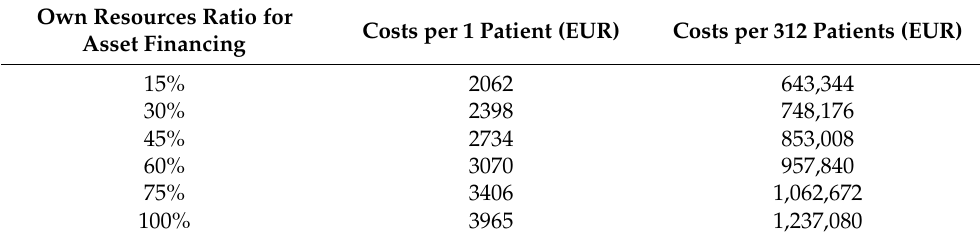
Table 15. Sensitivity analysis on changes to depreciated amounts included in ABC costing—3DCTR. Own Resources Ratio for Asset Financing